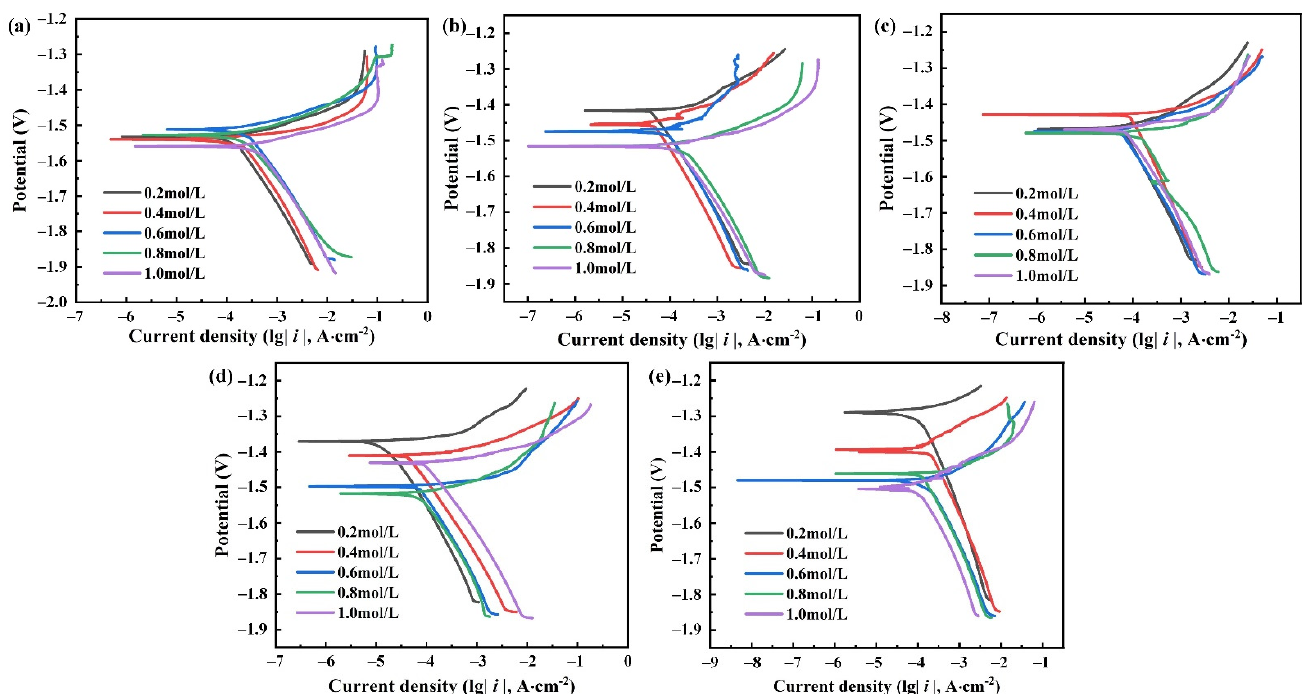
Figure 6. Polarization curves of ZK61M alloy with different time immersed in Cl − solutions: ( a ) 0 h, ( b ) 4 h, ( c ) 8 h, ( d ) 18 h and ( e ) 36